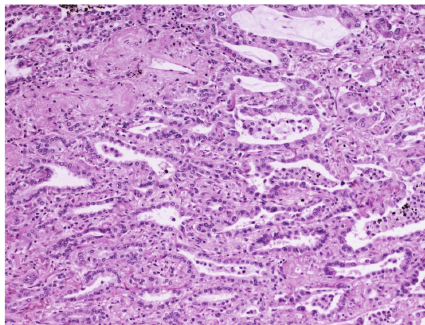
Figure 5: Adenocarcinoma component with acinar growth pattern (H&E × 10